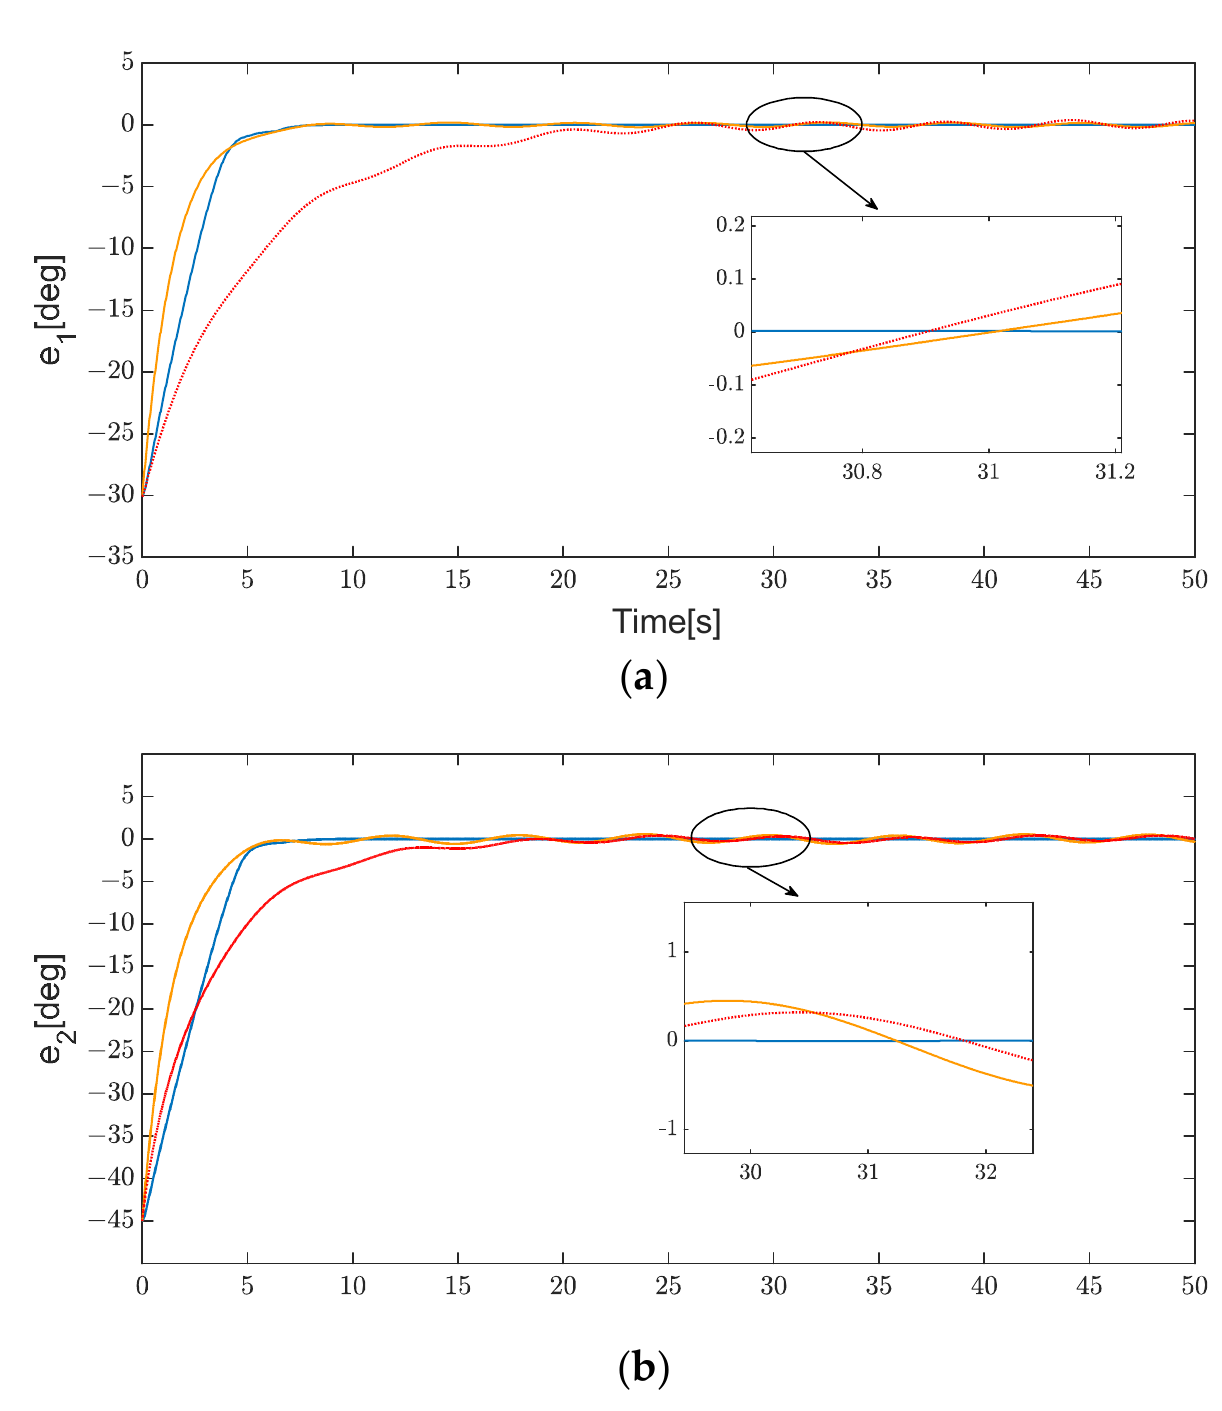
Figure 10. Comparison of angular position to [26,33] in case 2: the [26] scheme (yellow solid line), the [33] scheme (red dash line), the proposed scheme (blue solid line), the reference angular position (green dashed line), the angular position constrains (black dashed line); ( a ) Joint 1. ( b ) Joint 2.